Question: Condense the content of this figure into a single sentence.
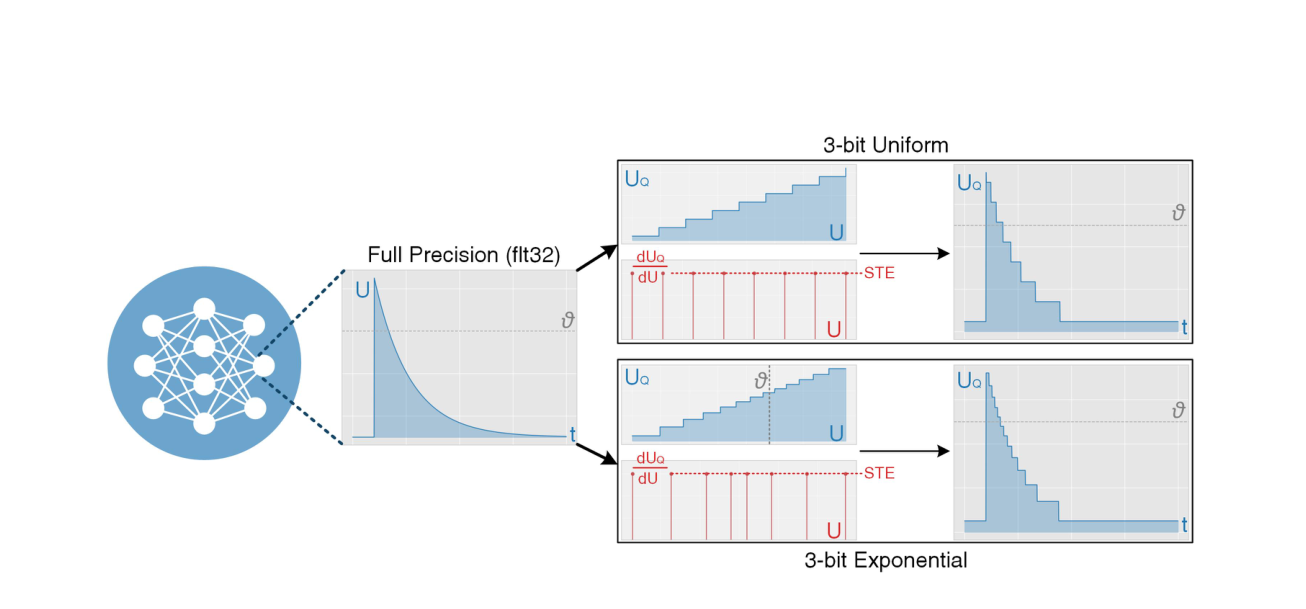
Answer: A graphical depiction of stateful quantization. On the left, a membrane potential trajectory is depicted in full precision. The state can be quantized either via uniform or exponential quantization. A 3-bit (8 levels) quantization scheme is illustrated. In uniform quantization, the permissible levels are evenly distributed. In exponential quantization, the permissible levels are closer about the threshold, and widely distributed moving further away from the threshold. A ‘straight through estimator’ (STE) is also depicted to address the non-differentiability of quantization.